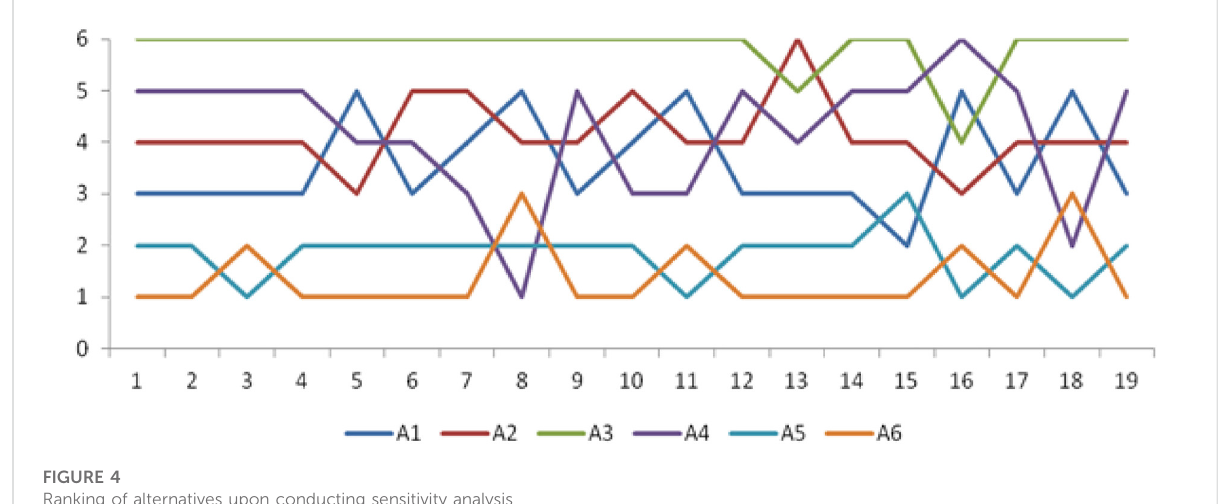
FIGURE 4 Ranking of alternatives upon conducting sensitivity analysis Source: according to authors